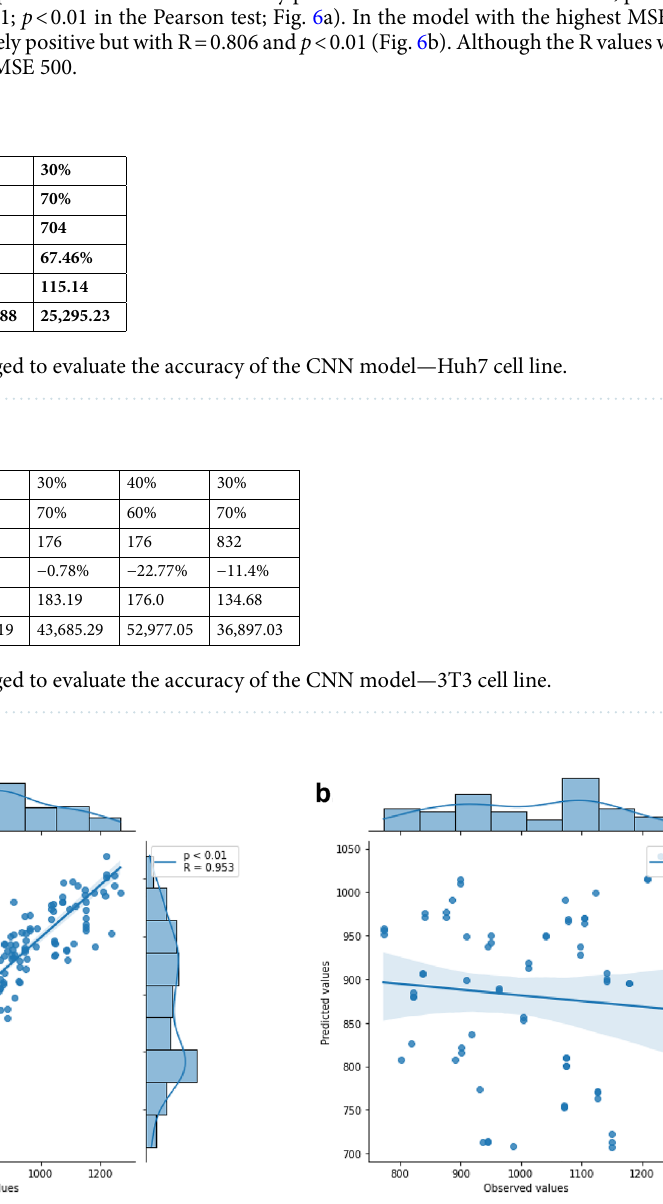
Figure 5. Pearson correlation between predicted and observed values. ( a ) Correlation based on the model that presented lower MSE in the A549 cell line. ( b ) Correlation based on the model that presented higher